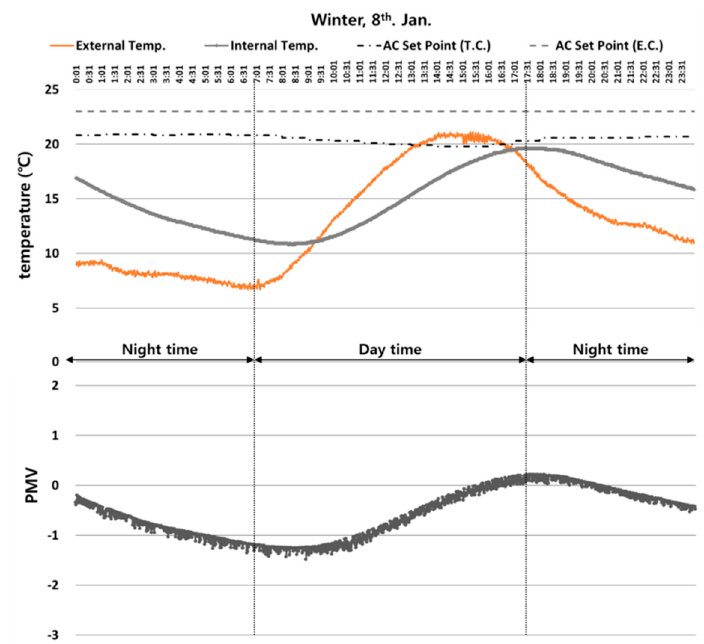
Figure 23. Experimental results recorded on January 8.